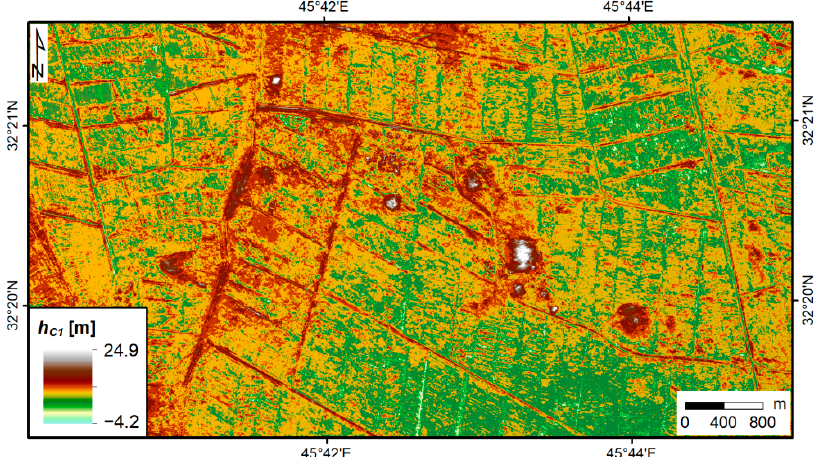
Figure 3. Zoomed view of the high resolution CartoSat-1 DSM product (©GAF AG. Includes material ©Antrix, distributed by GAF AG) enhancing the anthropogenic topographic relieves of T ū l ū l al-Baqarat tells from the surrounding agricultural fields in the eastern sector of the test area (see location in Figure 1c).